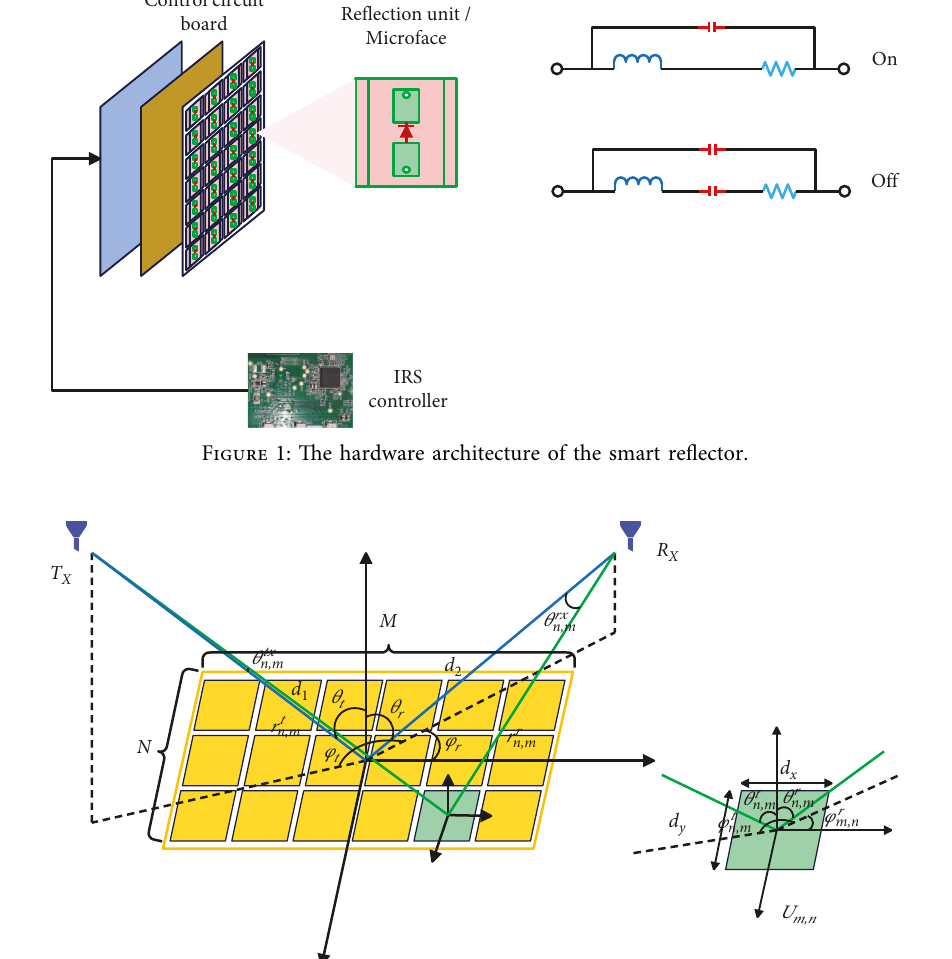
Figure 2: Physical model of the smart